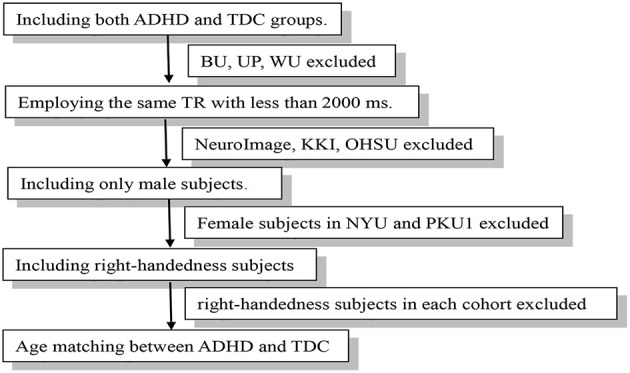
Flow-chart of data exclusion.